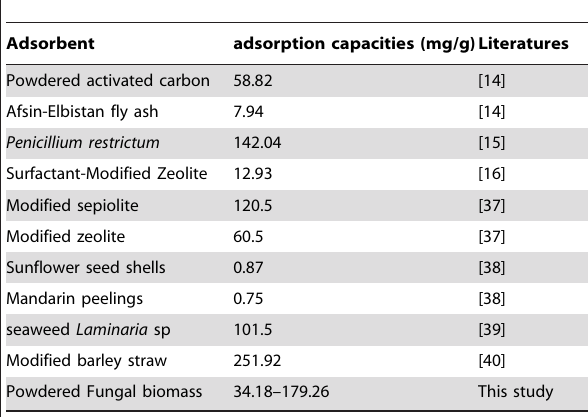
Table 3. Recent reported adsorption capacities (mg/g) for Reactive Black 5.